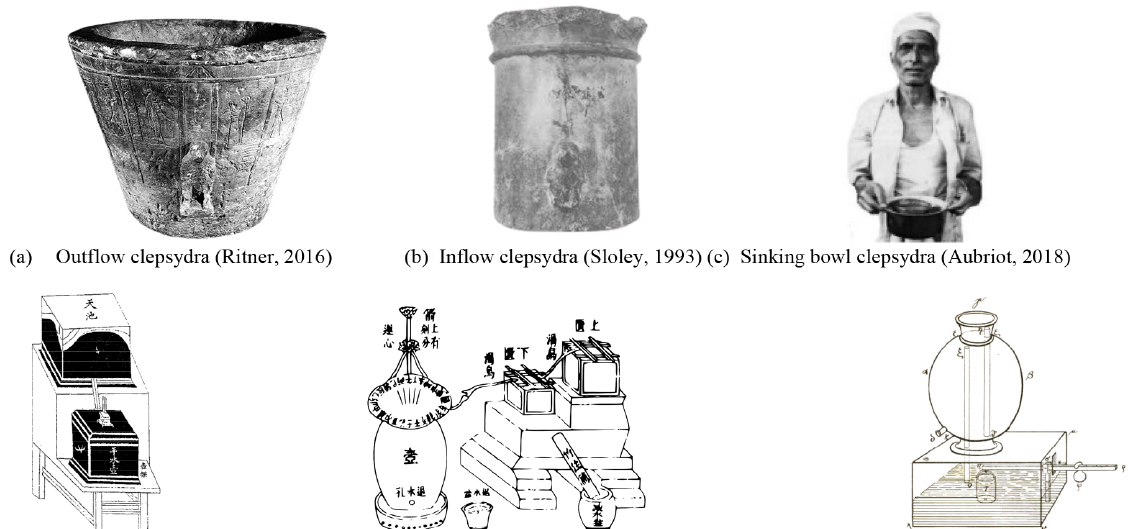
Figure 2. Examples of the six types of